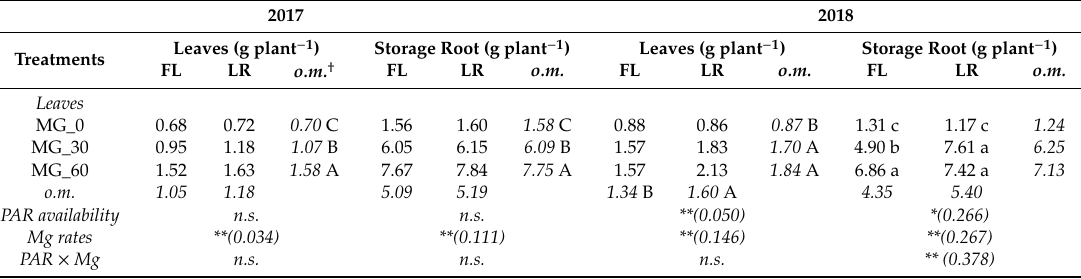
Table 1. Leaves and storage root dry mass accumulation of red beet plants subjected to two levels of photosynthetically active radiation (PAR) availability (100% PAR availability: Full Light, FL; 50%